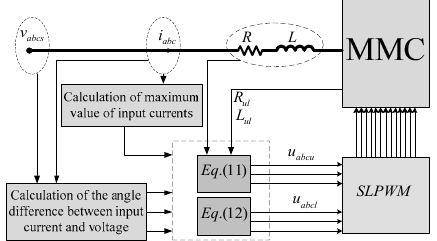
Figure 10. The overall structure of the proposed modulation functions for MMC.